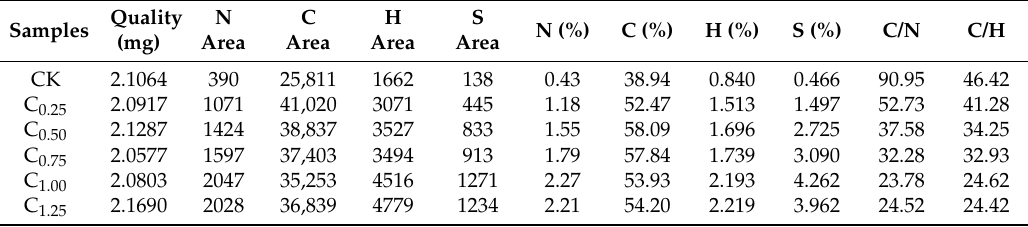
Figure 3. TGA analysis of different types of the cystamine-modified biochars. Table 1. Elemental analysis of different types of raw and cystamine-modified